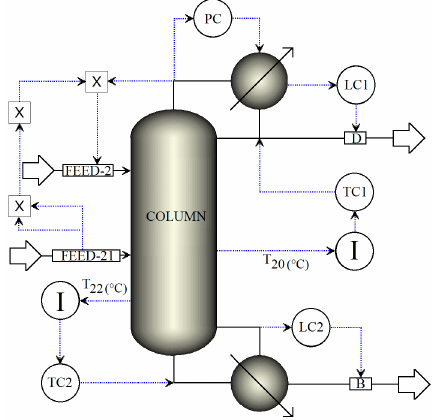
Figure 8. Structure RV with dual temperature